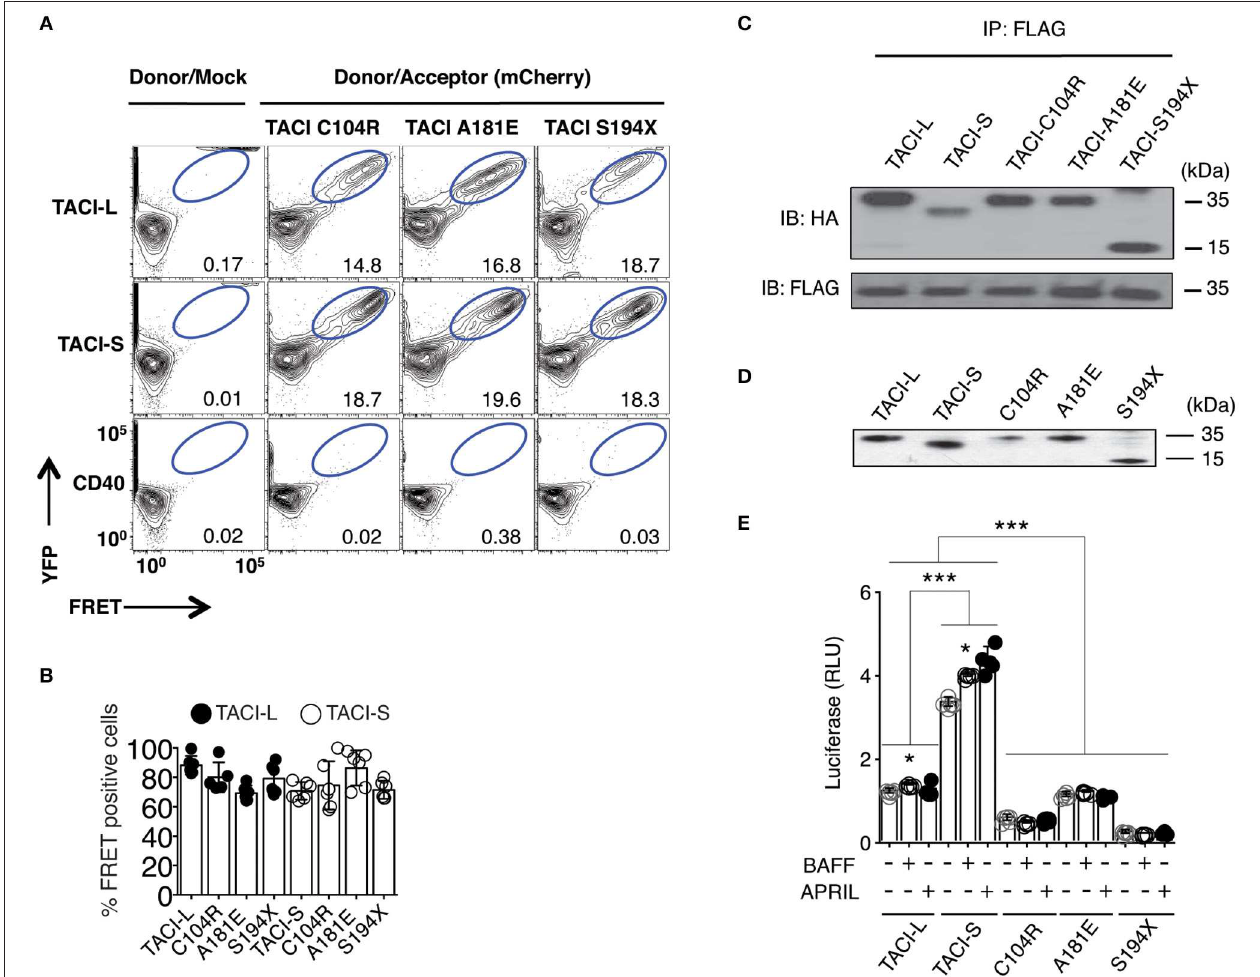
FIGURE 2 | TACI variants with missense mutations bind un-mutated isoforms but lack signaling function. (A) TACI mCherry labeled mutants, C104R, A181E, and S194X were generated in the TACI-L and TACI-S isoforms, and co-transfected into HEK - 293T cells with WT TACI-YFP. These were examined in FRET experiments by FACS (LSRII) to judge complex formation using CD40-eYFP as a control. The dot plot results in each panel, are shown for one sample, representative of the results for 6 different experiments. The numerical data given in each panel, are the percent of FRET positive cells, of the live cells in the gate, averaged for all 6 experiments. (B) Frequency of FRET positive cells in the double positive YFP and mCherry gate. Data shows average ± SD from 6 independent experiments. In other experiments, ligands, APRIL, or BAFF (0, 5, 20, or 50ng/ml) were added to judge the effects on FRET signal, showing no alteration in the signal (not shown). (C) For validation of complexes found in FRET, complexes forming with FLAG-TACI were precipitated with anti-FLAG sepharose beads and run on 10% PAGE gels; immunoblots were developed with an anti-HA antibody. Lower panel shows FLAG expression control. (D) To examine NF-kB luciferase induction, TACI-S, TACI-L or mutant C104R, A181E and S194X constructs were transfected into HEK-293T cells, along with NF-kB–luc reporter and control pRL-null plasmids and cultured for 48h; TACI expression was confirmed by western blot. (E) These cells were cultured with or without activation for 6h with 100ng/ml APRIL or BAFF. Reporter gene activity was determined, and NF-kB luciferase induction normalized to Renilla luciferase. Values reported are represented as Relative Luciferase Activity (RLA) and are the mean ± SD from 5 to 7 independent experiments. * p < 0.05; *** p < 0.001, two-tailed paired Student t -test. Western blot shows that all constructions are expressed.